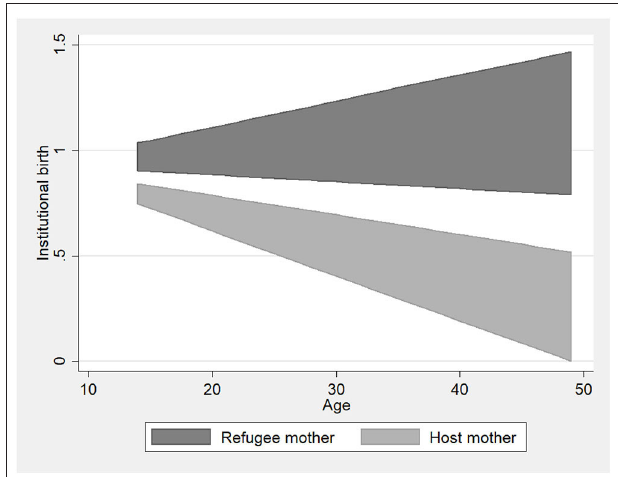
FIGURE 2 | Relationship between institutional birth and the Interaction between refugee status and age (based on Model